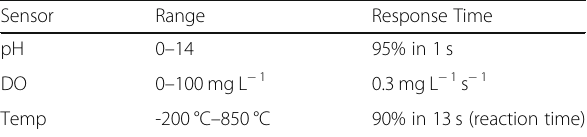
Table 2 Comparison of values taken using the developed prototype and Horiba®